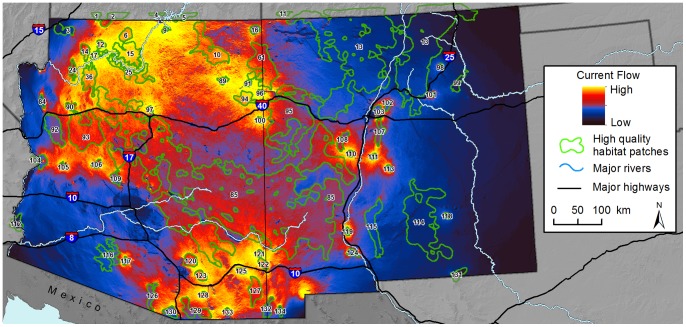
Model of cumulative current flow used to estimate connectivity for pumas across the entire network of habitat patches.Maps were displayed using a histogram equalize stretch. Background maps were produced using data obtained from the U.S. Geological Survey’s Earth Resources Observation and Science Center.